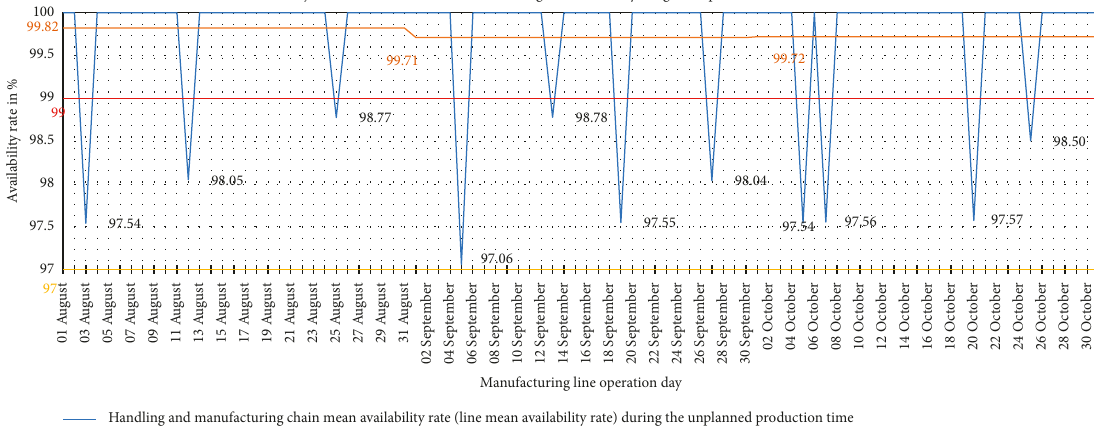
Figure 2: Manufacturing line mean availability rate during the unplanned production time and monthly availability rate averages compared to the maintenance objectives in matters of the manufacturing line availability over August, September, and October 2021.